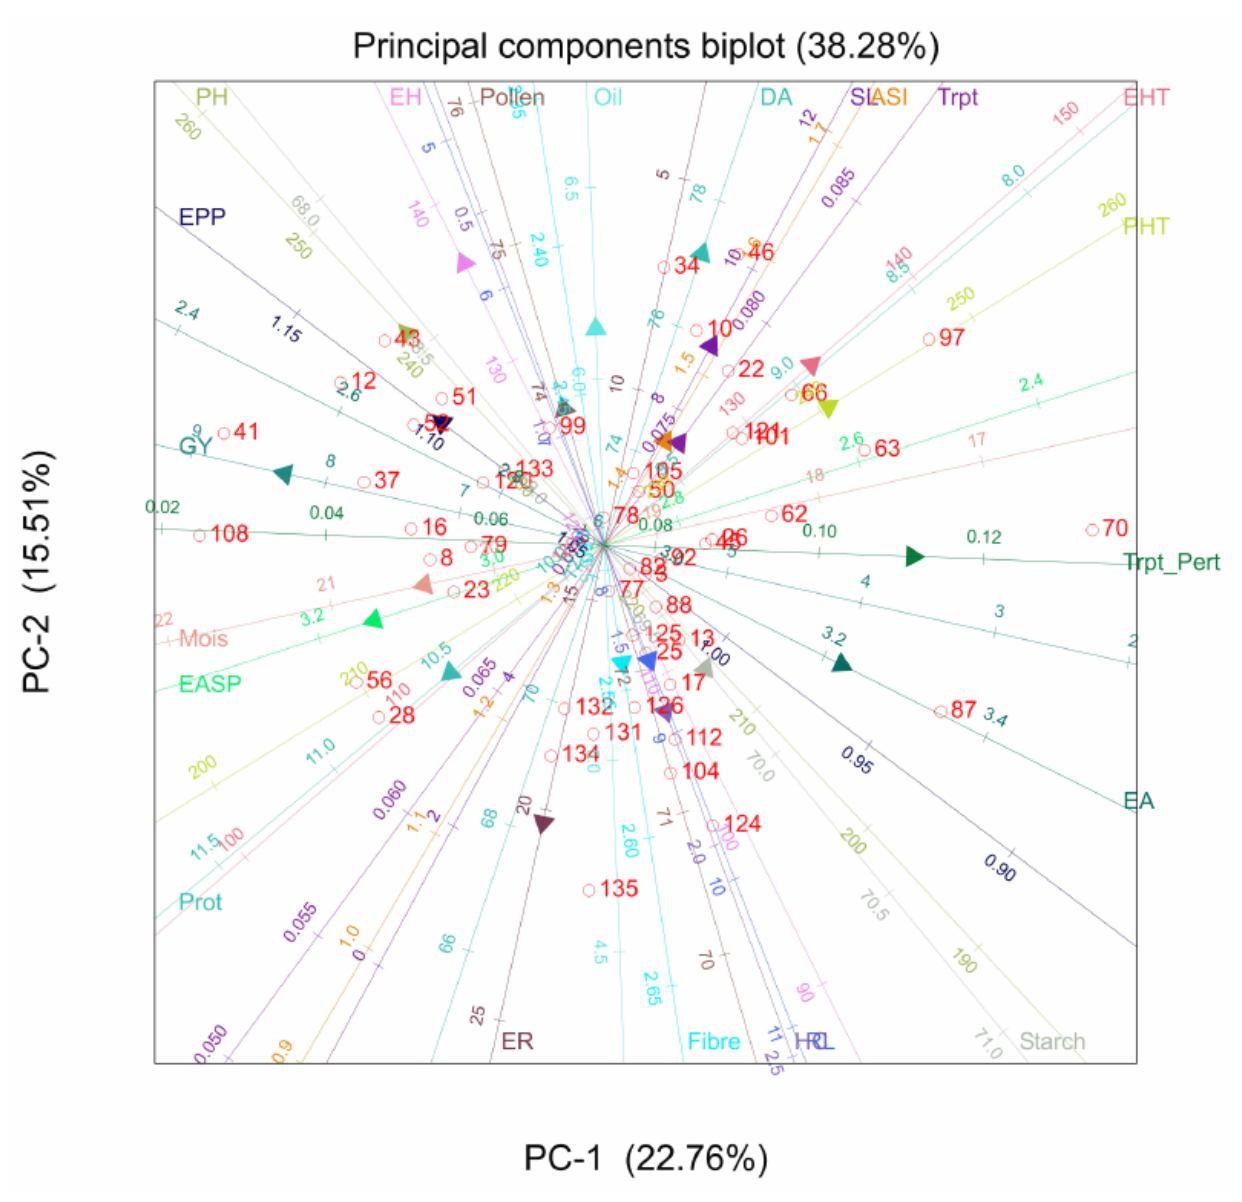
Figure 2. Principal component analysis biplot of genotype by quality traits of 135 QPM and non-QPM hybrids evaluated across six locations: Trypt_Pert, tryptophan; Prot, protein.